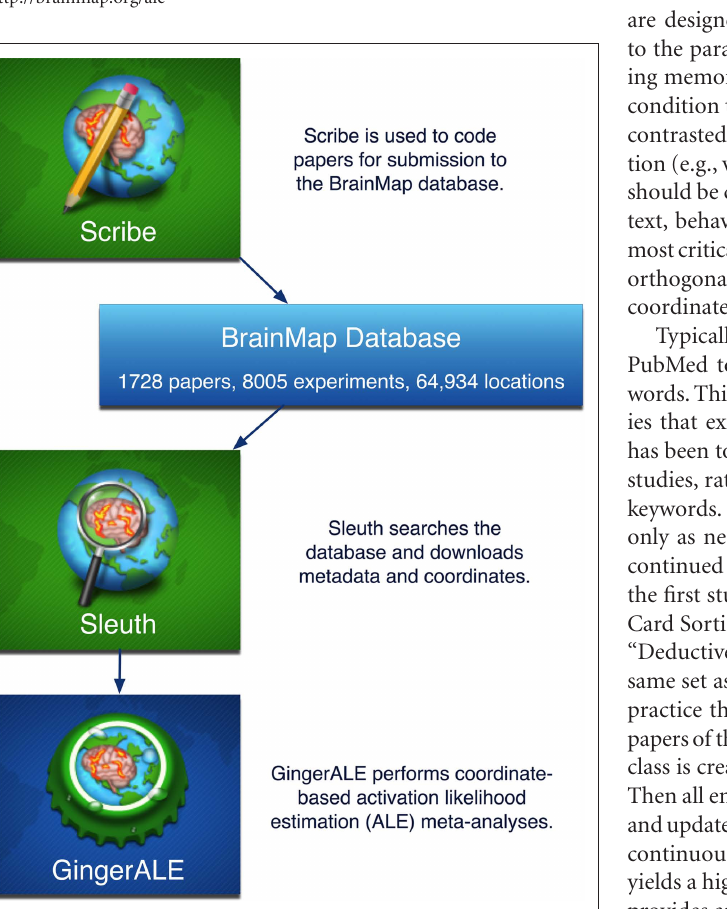
FIGURE 1 | BrainMap software applications. There are three desktop applications that allow interaction with the BrainMap database: Scribe (data entry), Sleuth (search and retrieval), and GingerALE (meta-analysis). These Java applications are freely downloadable from the BrainMap website (http:// brainmap.org). Database statistics are current as of